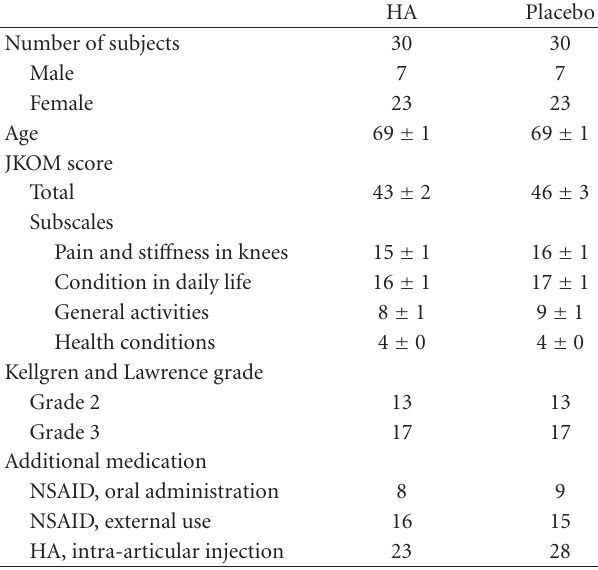
Table 1: Demographic and clinical characteristics of subjects at